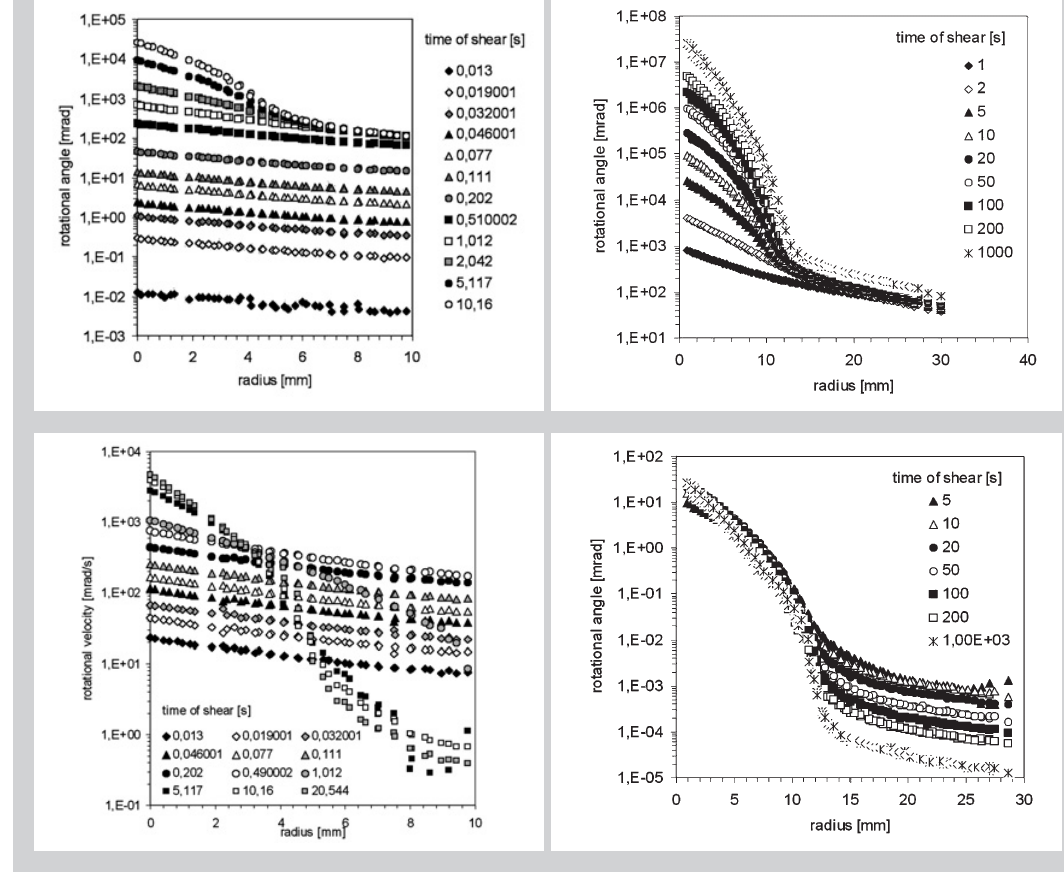
Figure 1 (above): Rotation angle inside a large gap rheometer and its evolution with experimen- tal time for a liquid sludge at 1.5% dry matter (left) and a diluted pasty sludge at 4.4% dry matter (right). The abscissa origin is the radius mobile. Figure 2 (below): Velocity profile inside a large gap rheometer and its evolution with experimen- tal time for a liquid sludge at 1.5 % dry matter (left) and a diluted pasty sludge at 4.4% dry matter (right). A steady state is reached at the vicinity of the mobile while the velocity decreases towards zero further. Each curve represents the rota- tional velocity or angle within the gap at a given